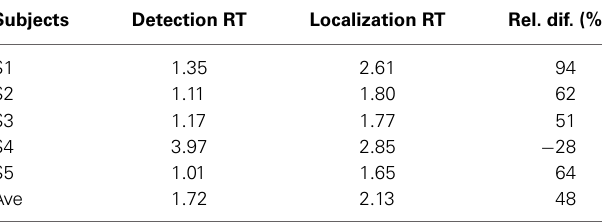
of reaction time in each quartile (B) is plotted against performance for the quartile. Averages and standard errors across subjects are